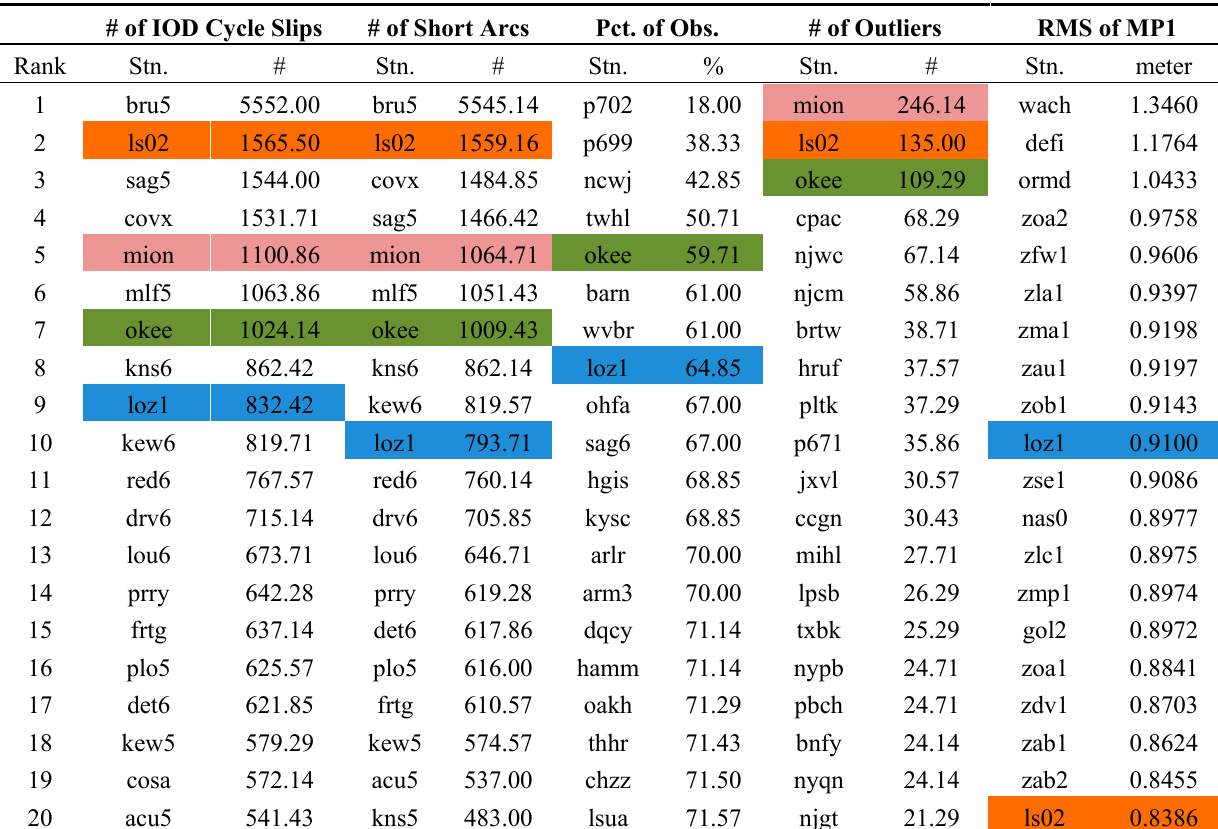
Table 3. Rank of CORS stations in CONUS (Worst station is on top for each quality